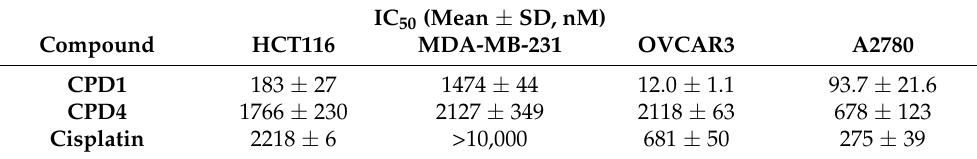
Table 3. Cell growth inhibitory activities (IC 50 values) of compounds CPD1 and CPD4. IC 50 (Mean ± SD, nM)